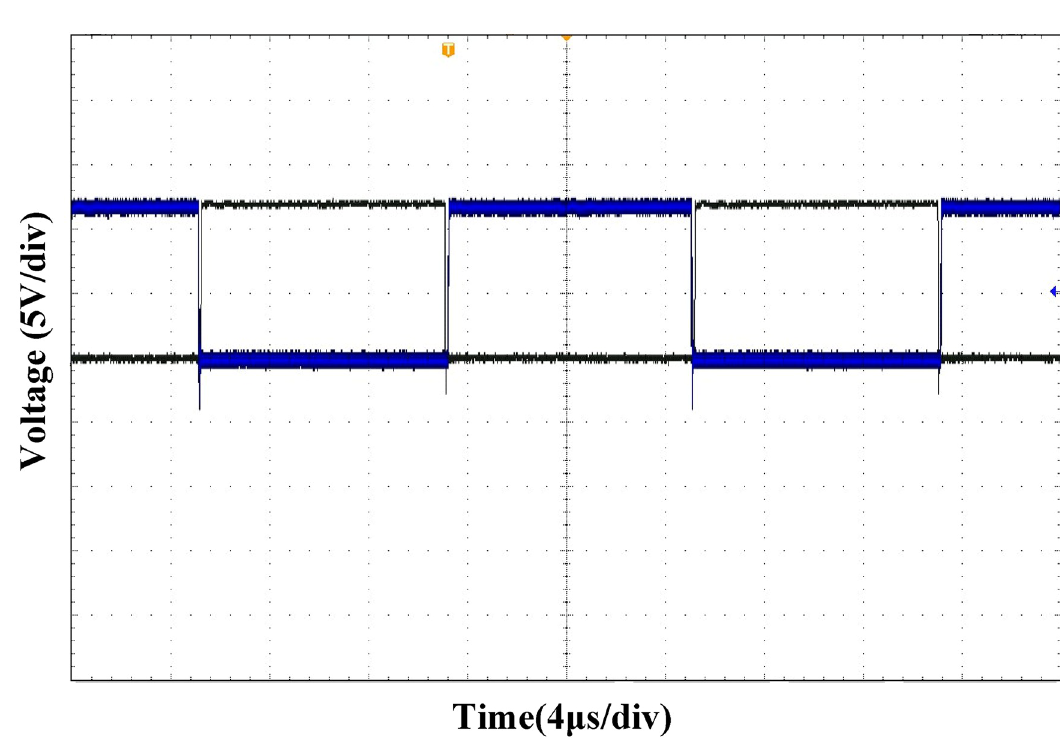
Fig 21. MOSFET driving waveform of the leading-leg.